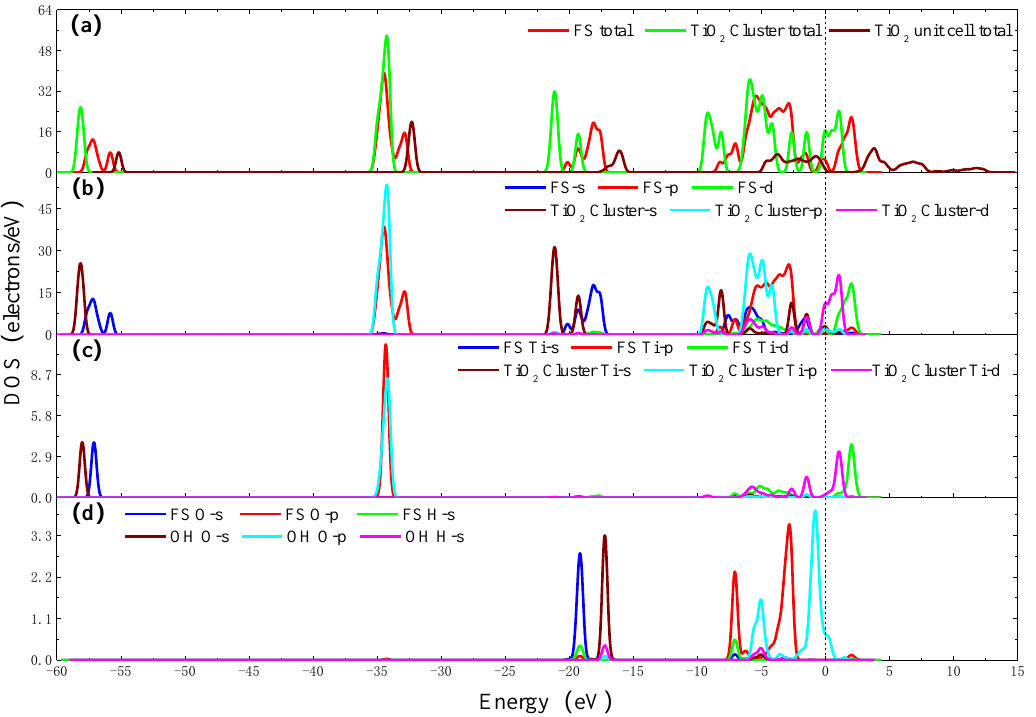
Figure 4. The density of states (DOS) of OH group adsorbing on the surface of TiO 2 cluster. ( a ) Total DOS of FS, TiO 2 cluster and TiO 2 unit cell; ( b ) Partial density of states (PDOS) of FS and TiO 2 cluster; ( c ) PDOS of adsorption site Ti atoms of FS and TiO 2 cluster; ( d ) PDOS of O atom and H atom of FS and OH group.